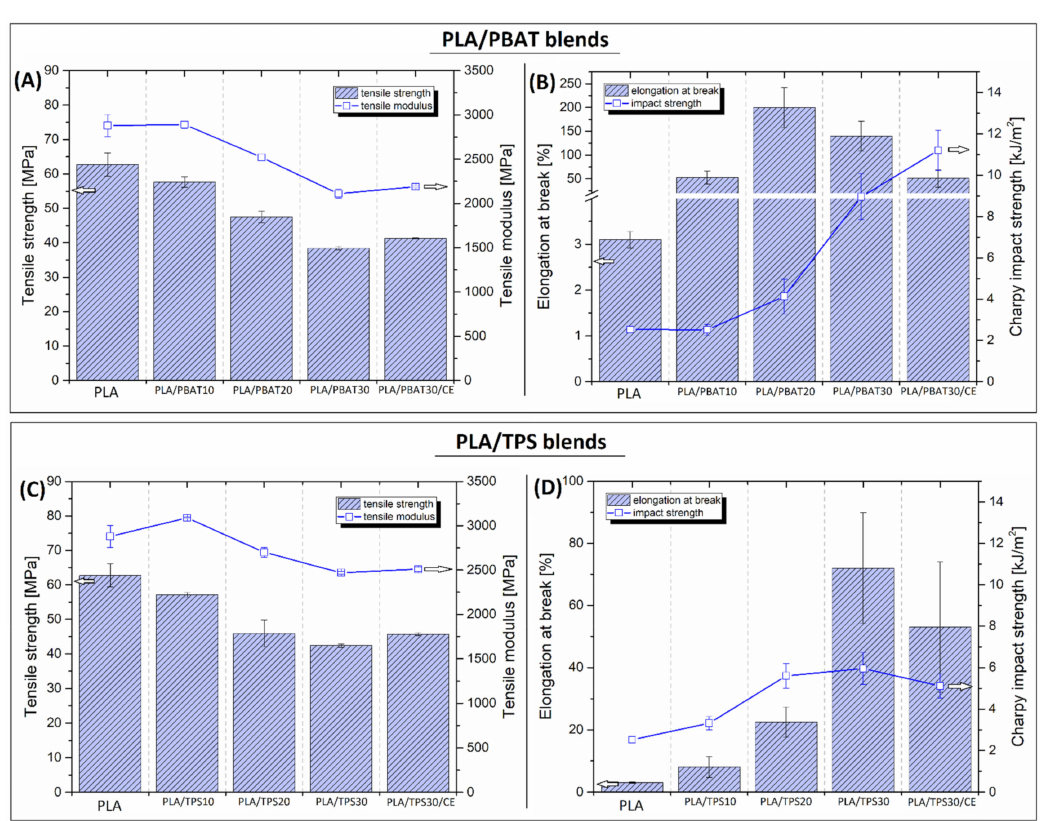
Figure 12. The results of the mechanical tests for injection-molded samples. Plots present the results of the static tensile test and impact resistance measurements in the form of tensile modulus, tensile strength, elongation at break, and Charpy impact strength. ( A , B ) PLA/PBAT-based samples and ( C , D ) PLA/TPS-based